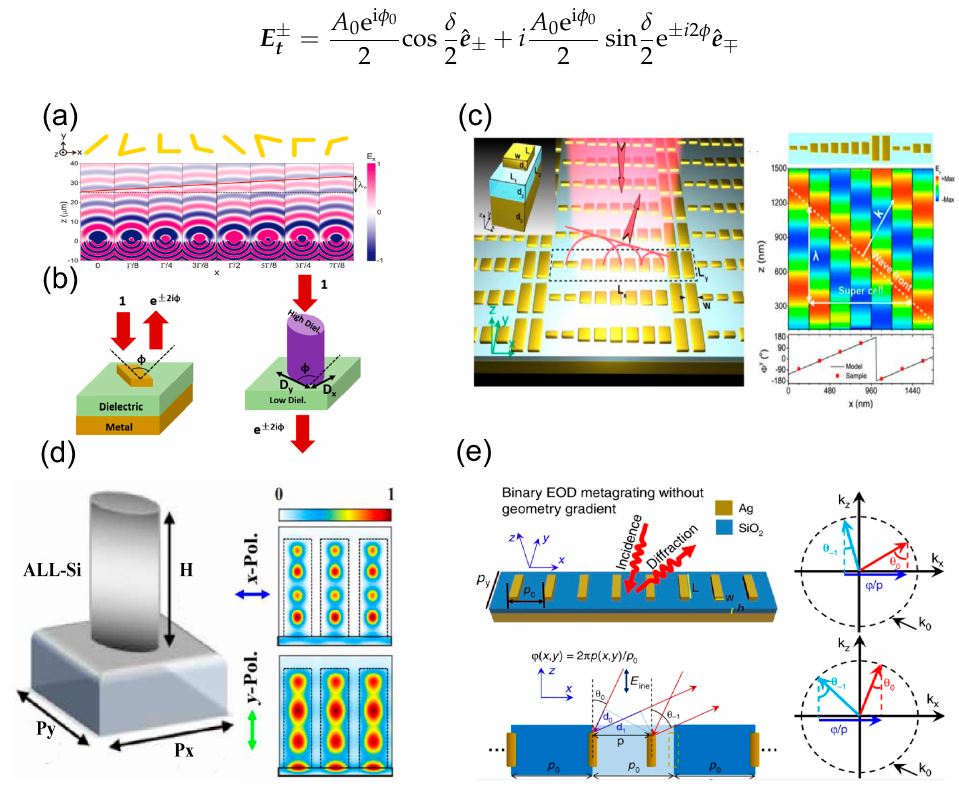
Figure 2. Phase control for metasurfaces. ( a ) V-shaped antenna array for demonstration of generalized laws of reflection and refraction [51]. ( b ) Geometric-phase-based metasurface [155]. ( c ) Resonant-phase-based metasurface for wave-shaping [156]. ( d ) The principle of the propagation phase based on monocrystalline Si meta-atoms [157]. ( e ) Schematics used to illustrate the principle of the detour phase that is proportional to the displacement, p